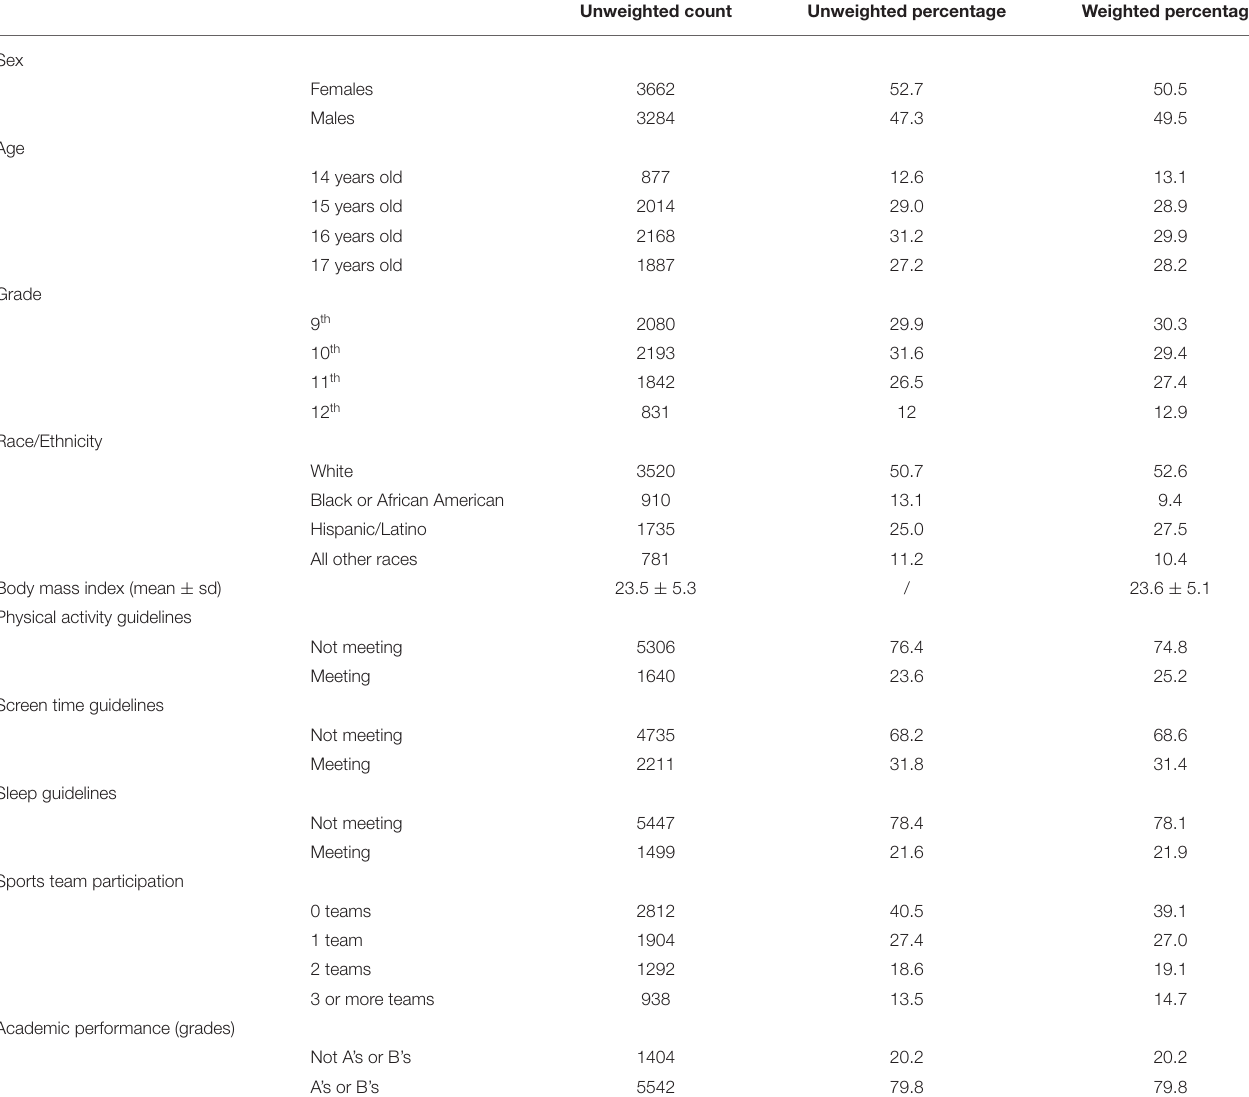
TABLE 1 | Descriptive results of the study sample, both weighted and